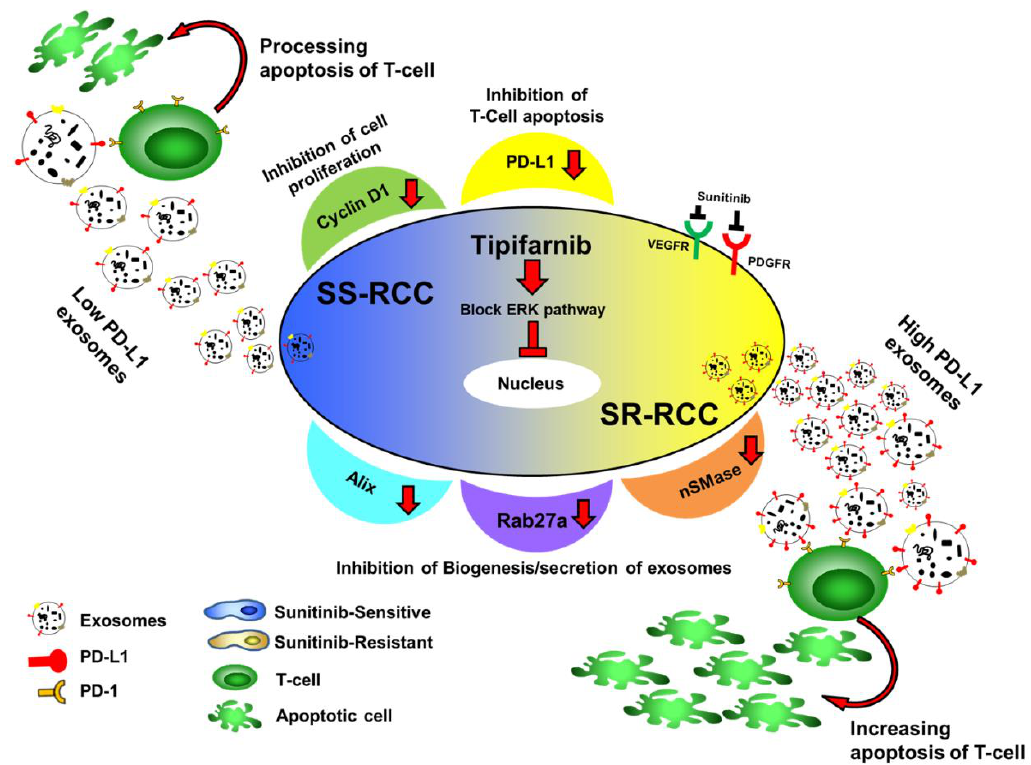
Figure 7. Illustrative diagram displaying this study’s proposed mechanism by which tipifarnib combats therapeutic resistance within the RCC microenvironment.